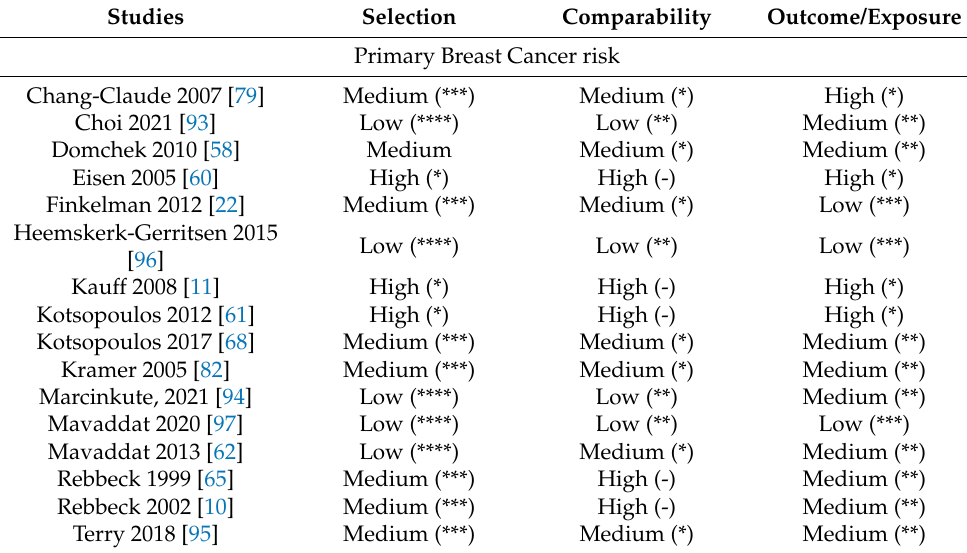
Table 2. Risk of bias assessment using the Newcastle–Ottawa